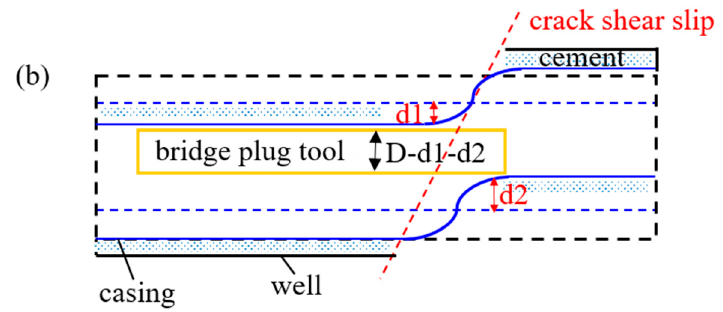
Figure 7. Schematic diagram of casing deformation and bridge plug obstruction: ( a ) before deforma- tion; ( b ) after deformation.